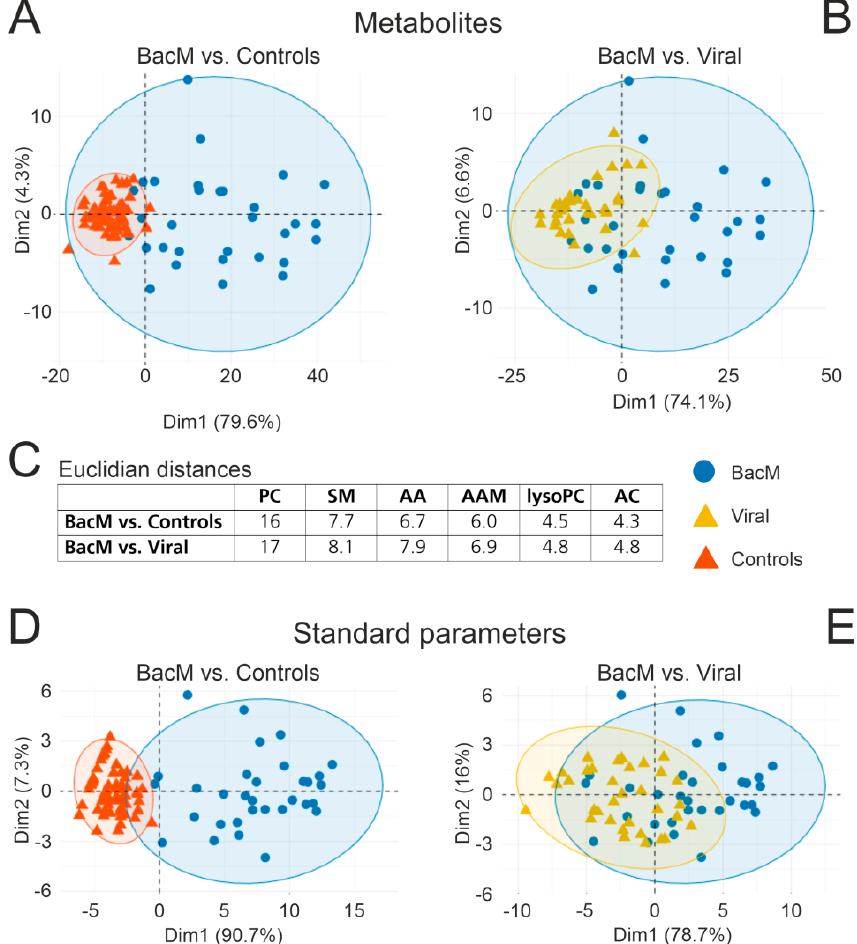
Figure 1. Differences in CSF metabolite populations between bacterial meningitis, viral CNS infec- tions, and noninflamed controls are driven by changes in phosphatidylcholine concentrations. PCA was performed on the basis of 99 CSF analytes (54 PC, 5 lysoPC, 12 sphingomyelins, 23 amino acids and amino acid metabolites, 5 acylcarnitines) and 7 standard diagnostic CSF parameters (leukocyte count, lactate, protein, BCB disruption, Q albumin, IgG Index, Q IgG). ( A ) Bacterial meningitis vs. controls (metabolites). ( B ) Bacterial meningitis vs. viral CNS infections (metabolites). ( C ) Mean Euclidian distances (reflecting global changes in individual metabolite classes) between bacterial meningitis and controls or viral CNS infections. ( D ) Bacterial meningitis vs. controls (standard parameters). ( E ) Bacterial meningitis vs. viral CNS infections (standard parameters). Abbreviations: AA, amino acids; AAM, amino acid metabolites; AC, acylcarnitines; lysoPC, lysophosphatidyl- cholines; PC, phosphatidylcholines; SM, sphingomyelins. BacM, bacterial meningitis; Viral, viral CNS